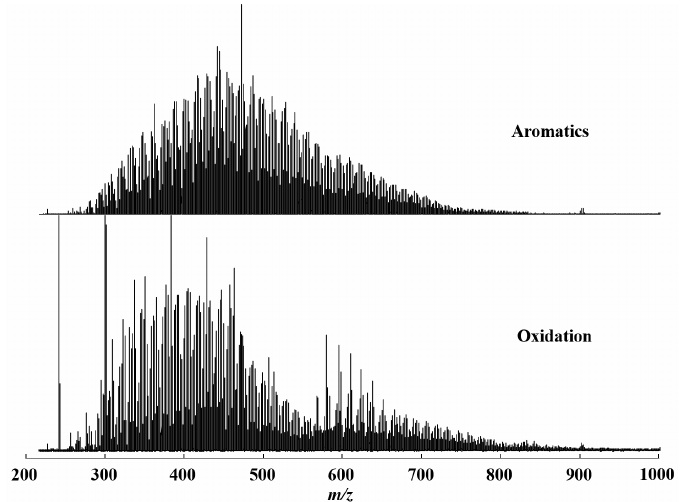
Figure 1. The mass spectrum of LGAR aromatics before and after selective oxidation.